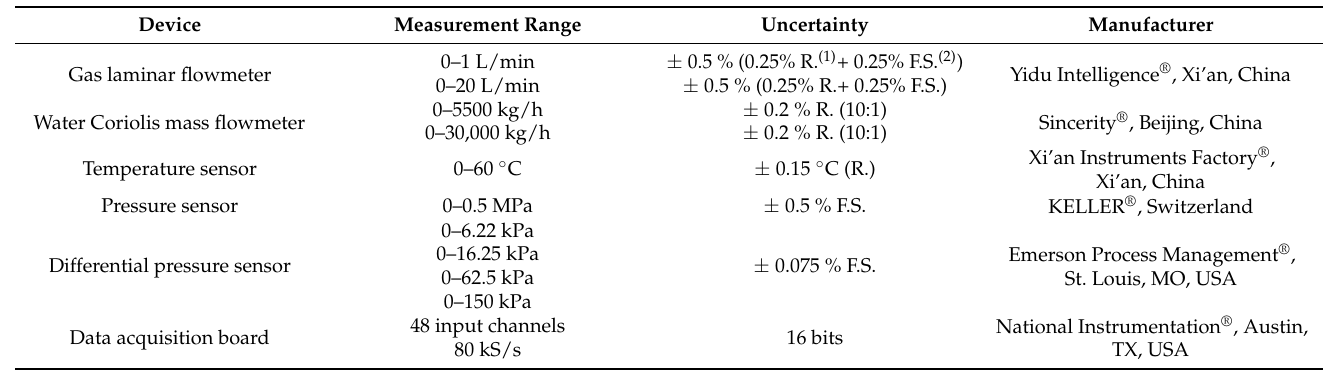
Table 1. Measurement devices employed in the experiments.